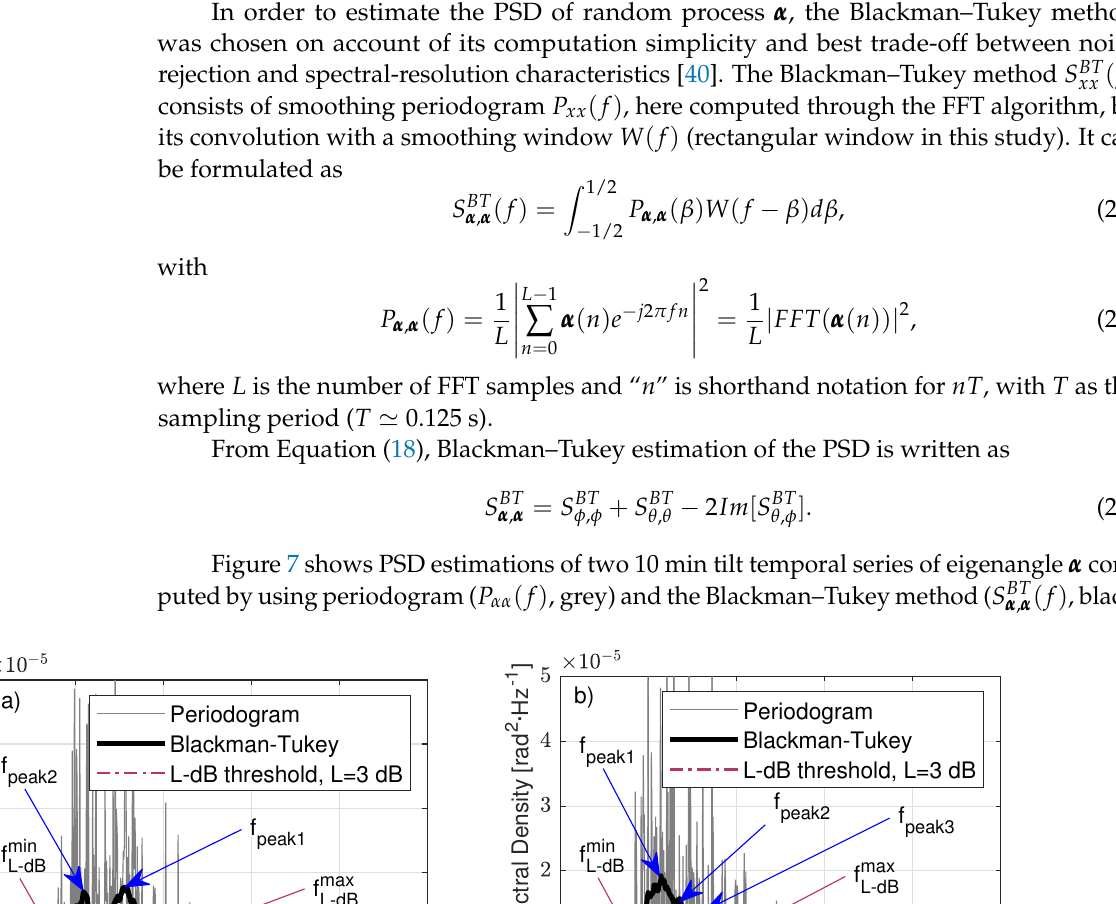
and f max , L − dB L − dB